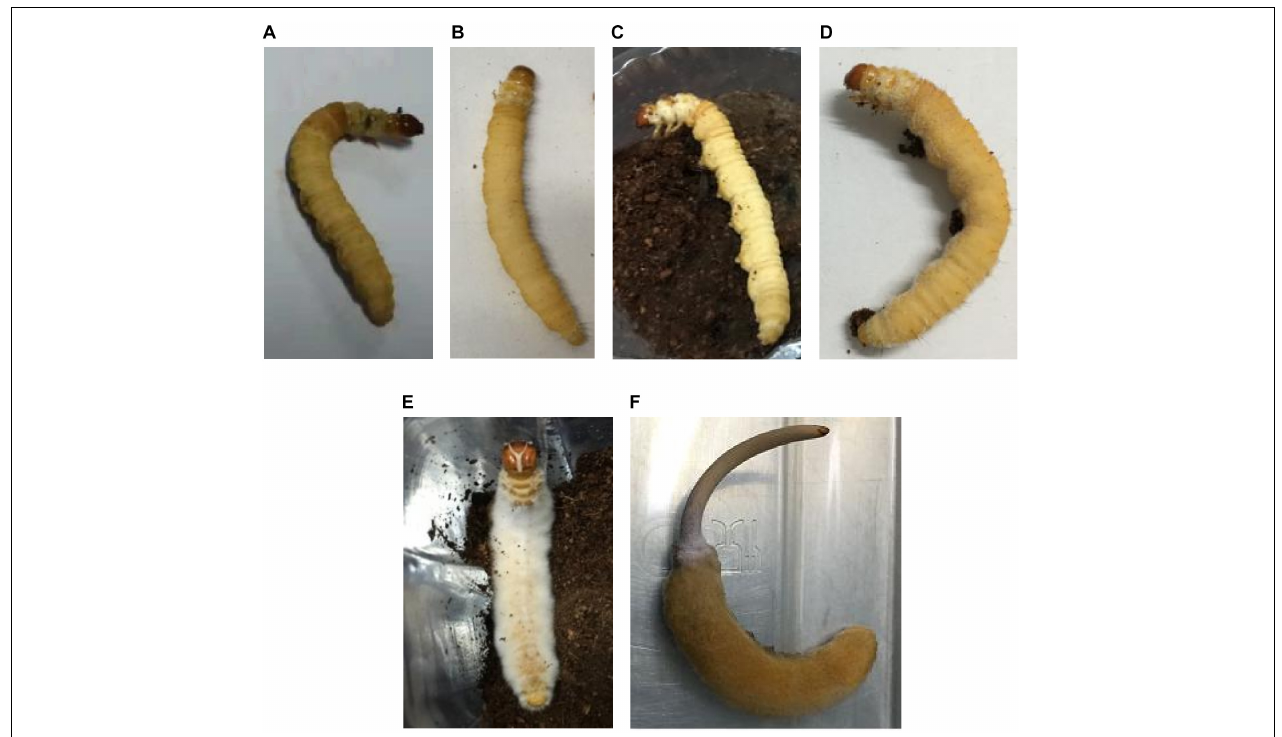
FIGURE 1 | Thitarodes larvae with or without Ophiocordyceps sinensis infection. Living larvae without injected fungi (A) , living larvae with high blastospore load (B) , mummifying larvae not coated with mycelia (C) , freshly mummifying larvae coated with mycelia (D) , completely mummified larvae with mycelia (E) , and Chinese cordyceps (F)